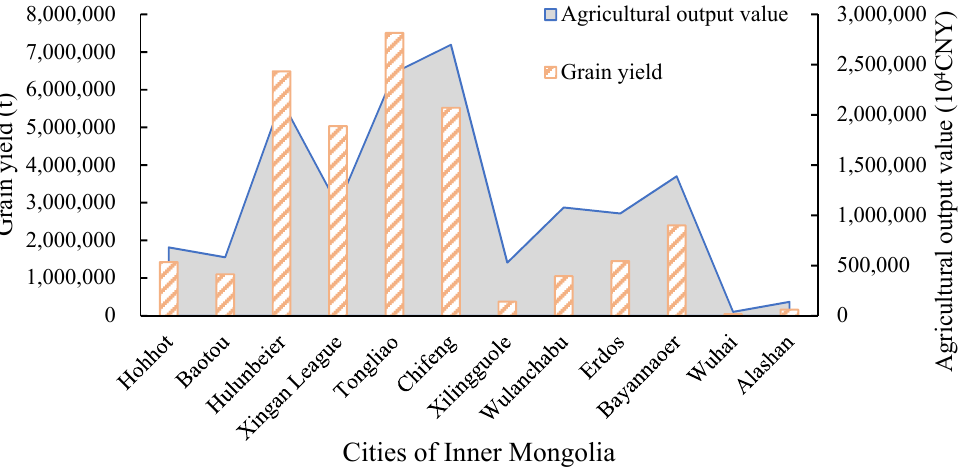
Figure 5. Agricultural output value and grain yield of Inner Mongolia. Table 2. Canal system data of Hetao Irrigation District.